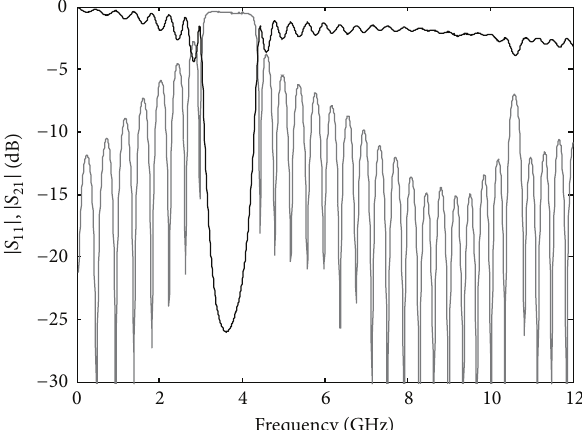
Figure 2: Measured |𝑆 21 | (black line) and |𝑆 11 | (grey line) parameter of the designed two-port EBG microstrip structure in Figure 1.